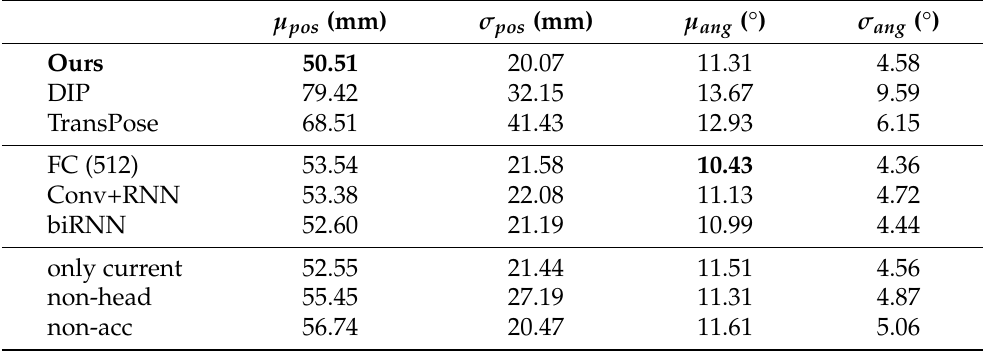
Table 1. The evaluation of our pose estimation network using different input variables and network architecture variants with the TotalCapture [18] dataset. The errors of each model are described as the mean ( µ pos ) and standard deviation ( σ pos ) of the joint position error in millimeters and the mean ( µ ang ) and standard deviation ( σ ang ) of the joint angle error in degrees